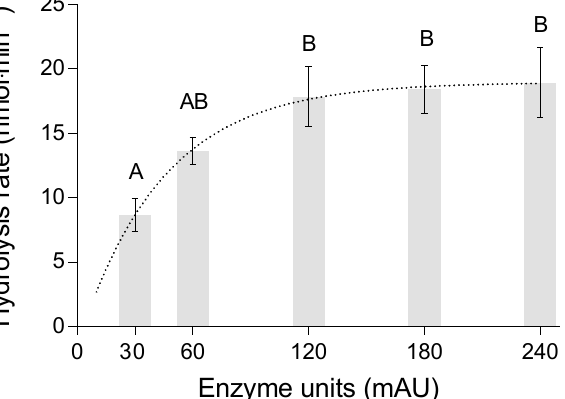
Figure 5. Rate of PLA hydrolysis (3 mg · mL − 1 ) at different quantities (Anson Units) of protease from Bacillus licheniformis at 22 °C and pH 8.2 (means ± SD, n = 2–3).